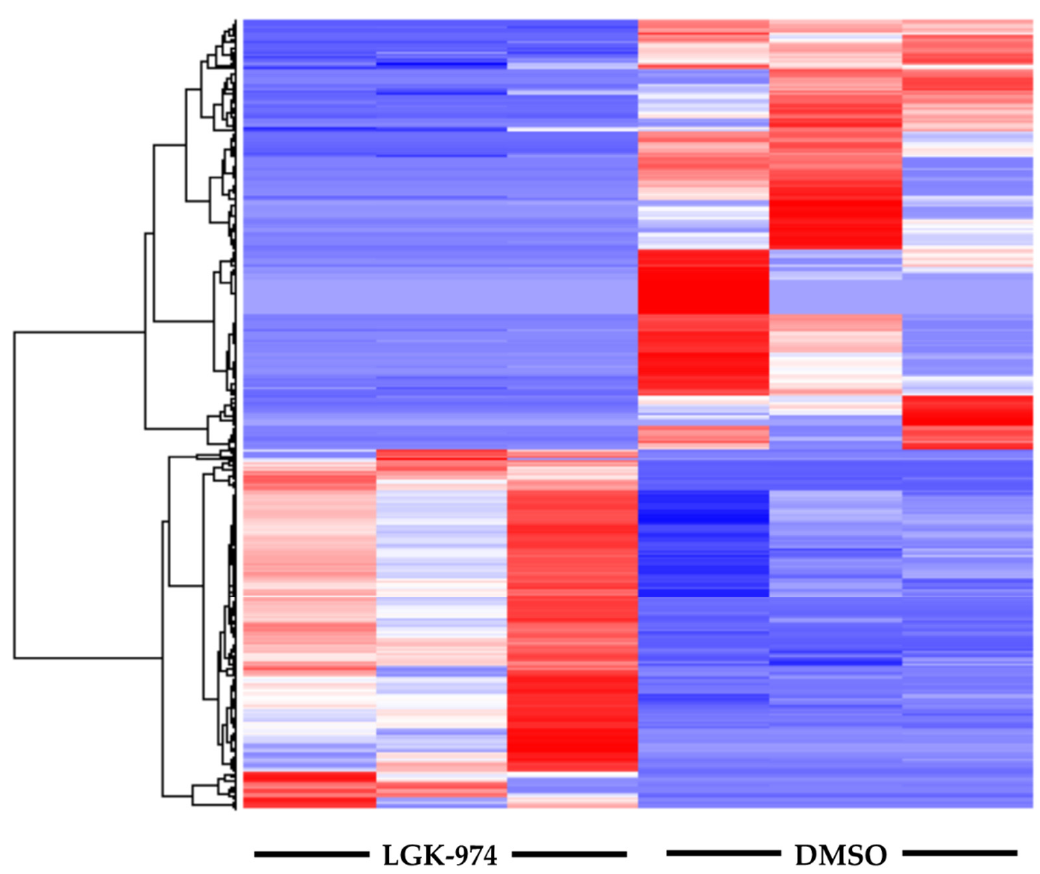
Figure 2. Heatmap of differentially expressed genes. Columns represent individual samples from the two groups. RNA-seq analysis revealed differential expression of 529 genes in heart tissue (from the infarct area) from animals treated with LGK-974 compared to DMSO (vehicle control). N = 3 per group.